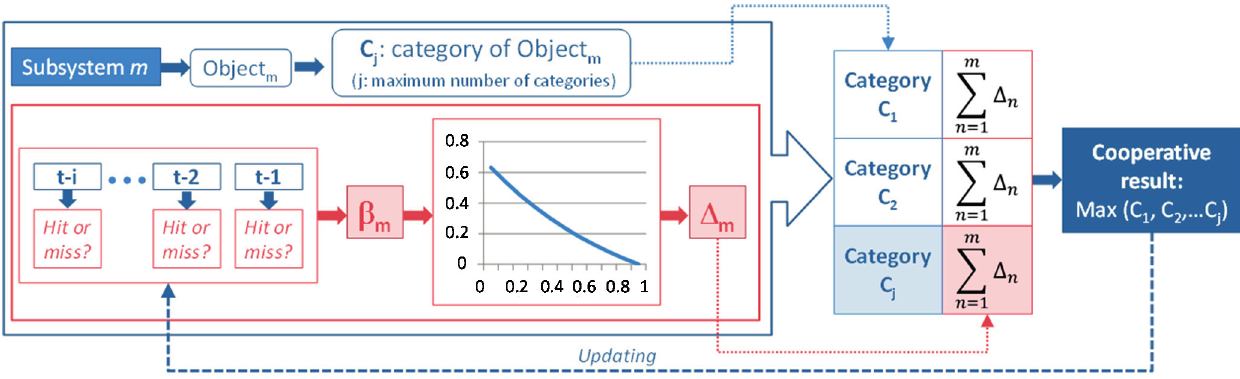
Figure 10. Procedure based on the last